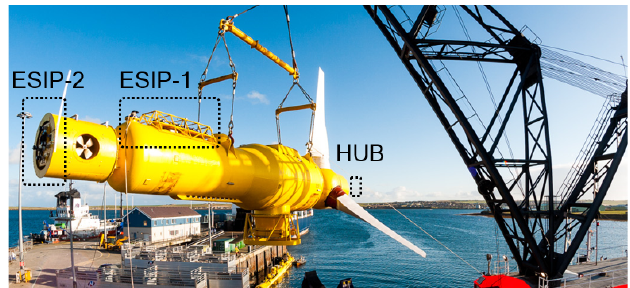
Figure 2. The DeepGen-IV 1 MW tidal turbine being deployed from Hatston Quay, Kirkwall, Orkney. Sensor platforms Edinburgh Subsea Instrument Platform 1 (ESIP-1) and ESIP-2 visible on the turbine top of the main nacelle and the left rear on the thruster housing. Turbine hub-mounted Single-Beam (SB)-ADP position indicated (HUB), but not visible at this image